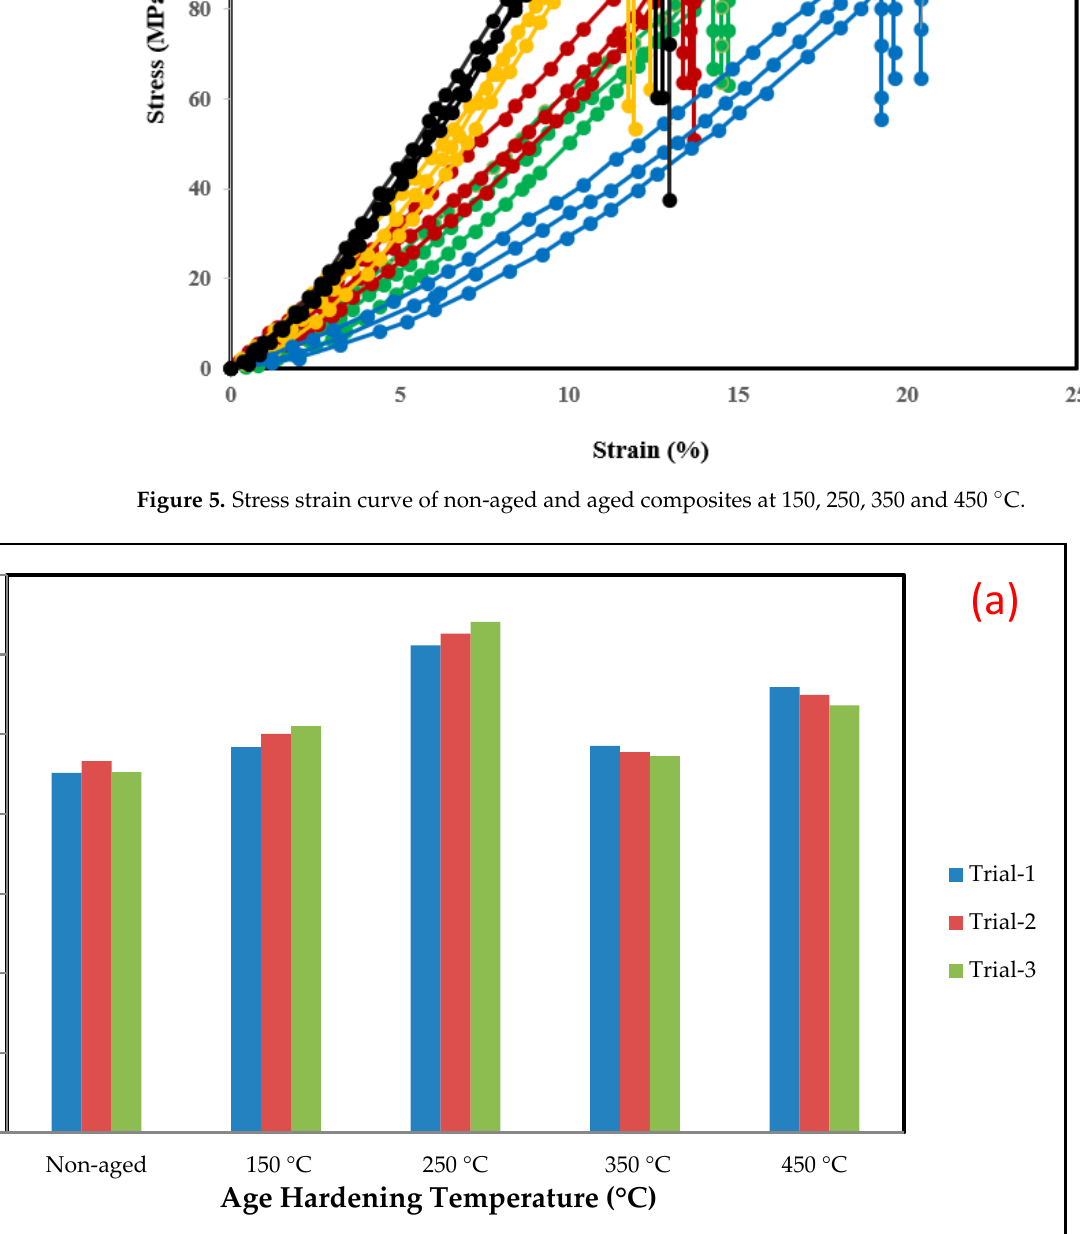
Table 4. Average tensile strength, impact energy and hardness of Al7075-WC composite.